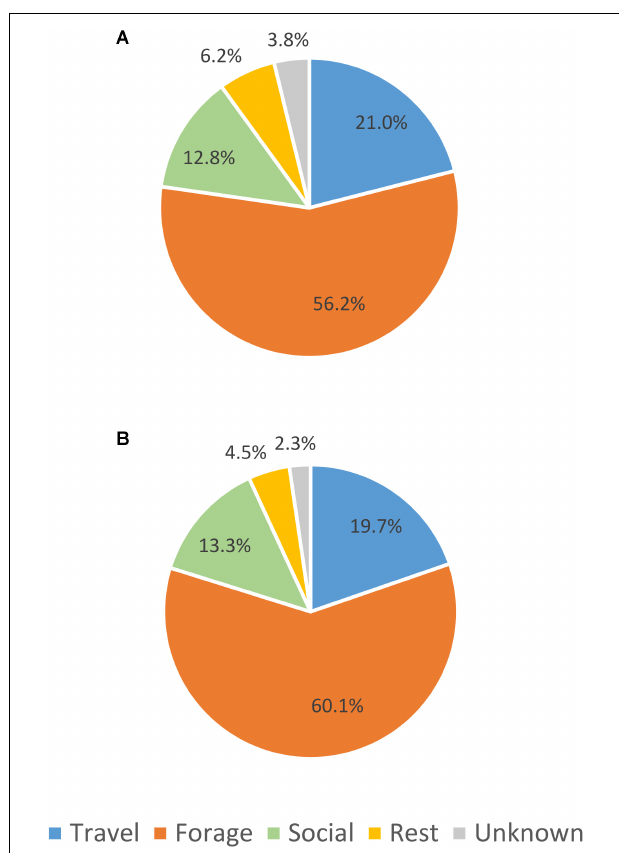
FIGURE 2 | Comparison of percent of activity budget for each primary gray whale behavior state between (A) UAS observed whale surface time and (B) UAS observed whale visible